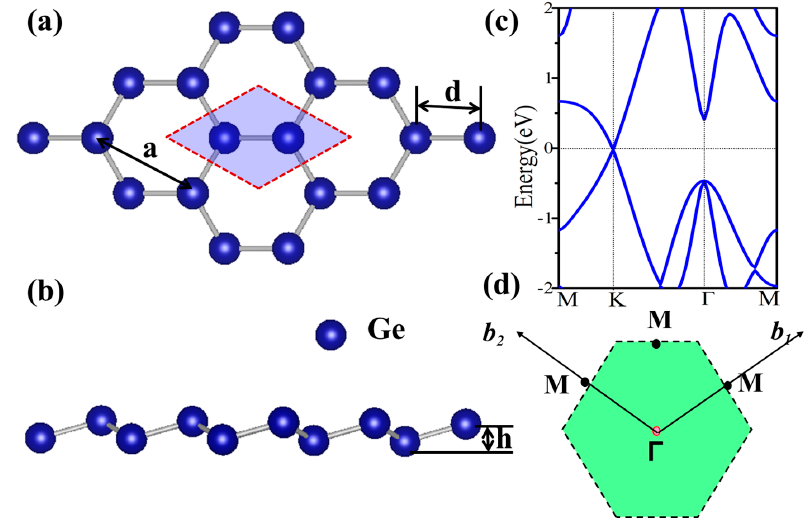
Figure 1. ( a ) Top and ( b ) side view of the atomic stuctures of germanene; ( c ) The energy spectra of germanene; ( d ) The schematic diagram of the first Brillioun zone.